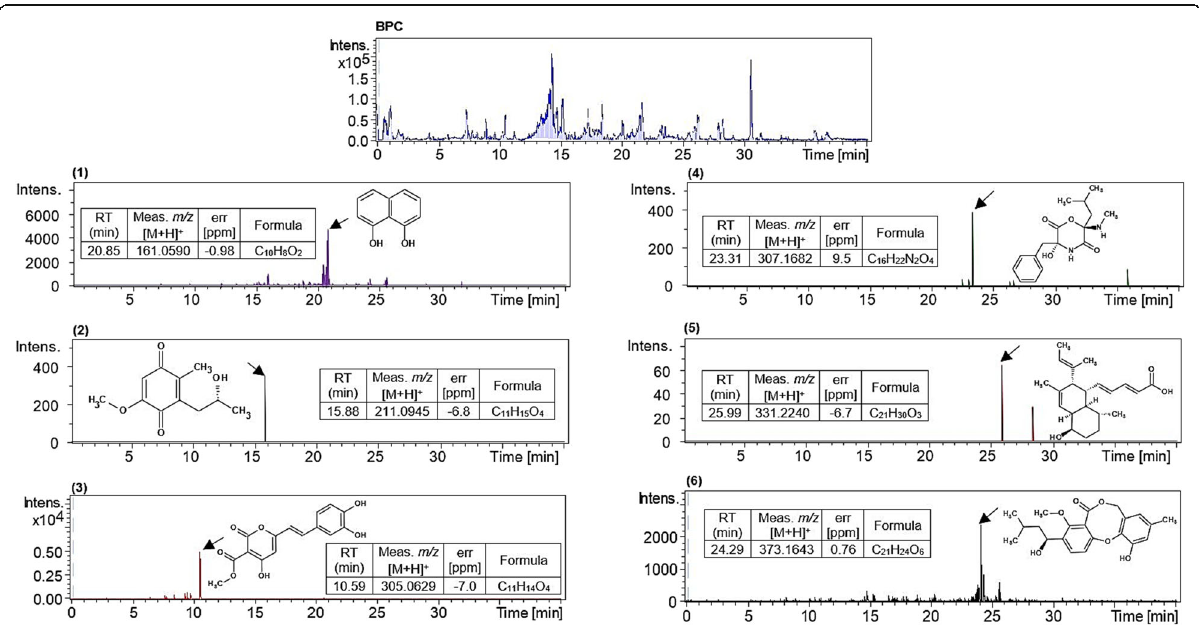
Fig. 4 The base peak chromatogram ( bpc) of Alternaria sp. KTDL7 ’ s crude extract and the extracted ion chromatogram (EIC) of identified secondary metabolites which are: 1,8-dihydroxynaphthalene ( 1 ), anserinone B ( 2 ), phelligridin B ( 3 ), metacytofilin ( 4 ), phomopsidin ( 5 ) and vermixocin A ( 6) . Meas. m/z denotes measured m/z , while Calc. m/z denotes calculated